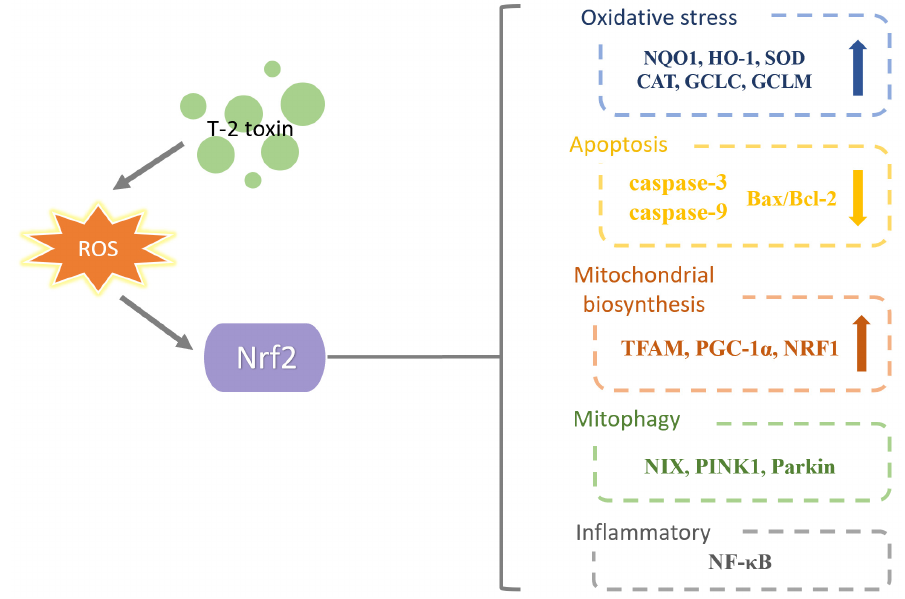
Figure 8. A current line of research on Nrf2 in T-2 toxin toxicity. T-2 toxin causes oxidative stress which affects Nrf2 expression. Nrf2 can increase anti-oxidative stress indicators, reduce apoptosis indicators, increase mitochondrial biogenesis indicators, affect autophagy indicators and affect inflammatory indicators.